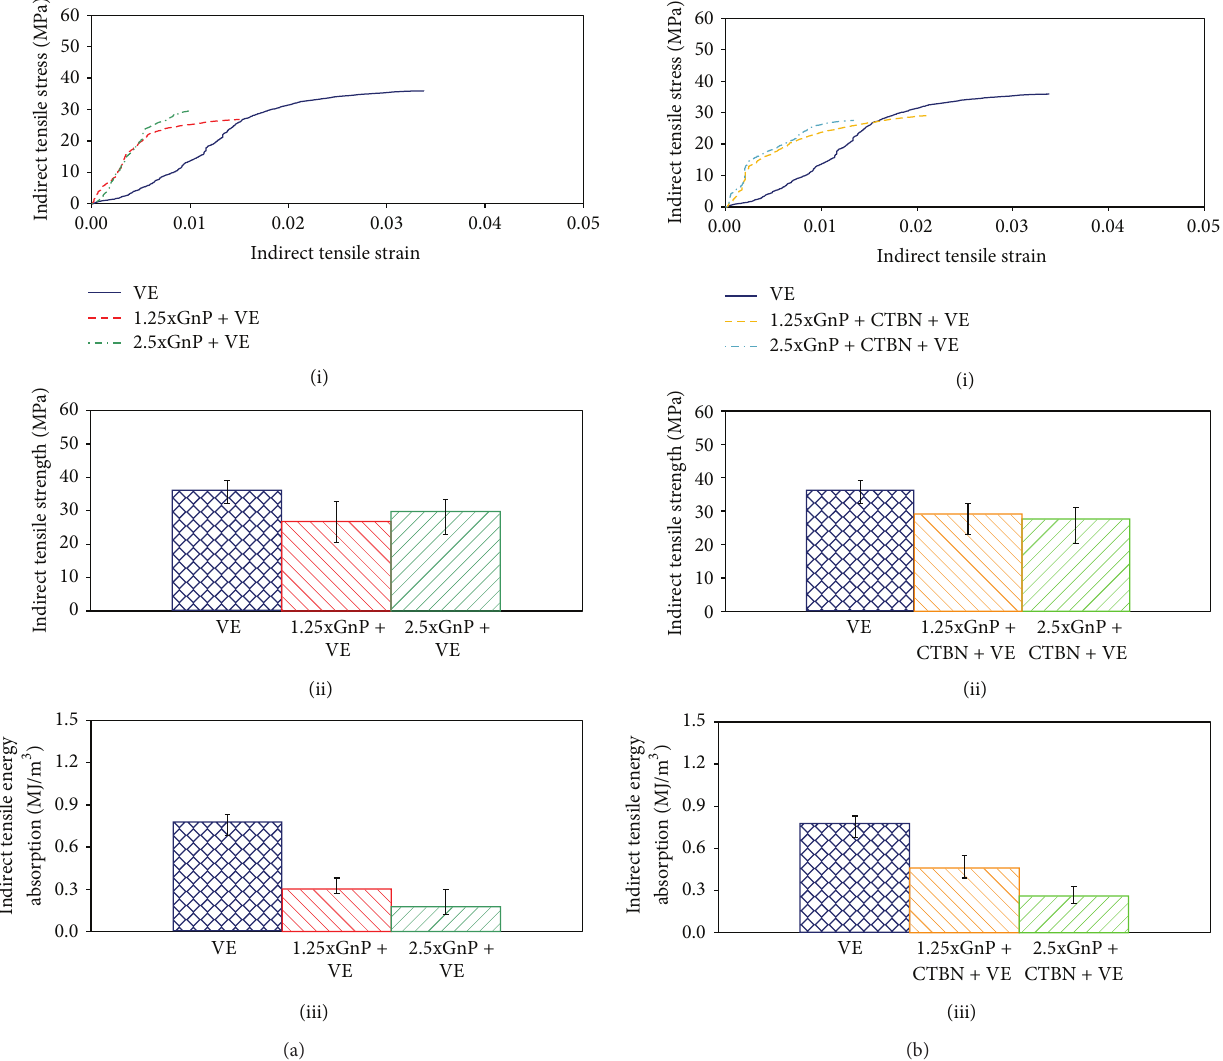
Figure 8: Quasi-static indirect tensile response. (i) Typical stress versus strain behavior, (ii) strength, and (iii) energy absorbing capacity of (a) graphite platelet reinforced and (b) with additional CTBN toughened vinyl ester nanocomposites (note: pure vinyl ester specimens did not fail within the 10 kN load cell limit of test equipment used for quasi-static